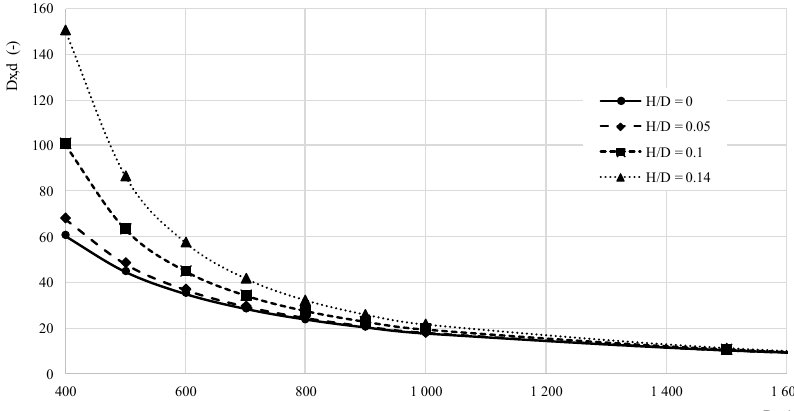
Figure 11. Results of the D x,d –Gaussian approximation function according to Equation (11), H/D is the sediment/pipe diameter ratio.